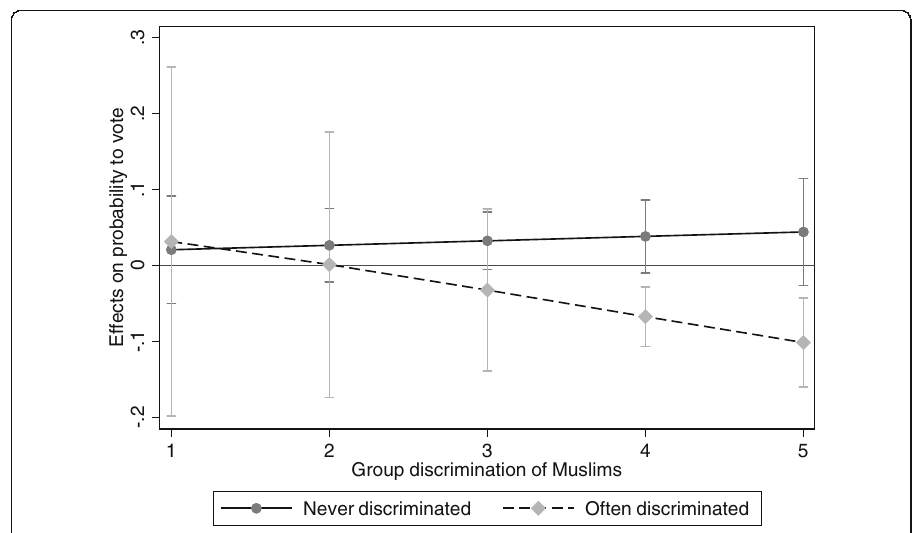
Fig. 5 Effects of Islamic identifications on local voting for different combinations of the perception of group discrimination and the perception of personal discrimination (TIES surveys 2007/2008). This graph shows the marginal effect of Islamic identification on the probability to vote locally (vertical axis) for different levels of perceived group discrimination of Muslims (horizontal axis) and levels of perceived personal discrimination. The solid line represents the respondents who never feel discriminated, while the dashed line represents the respondents who often feel discriminated